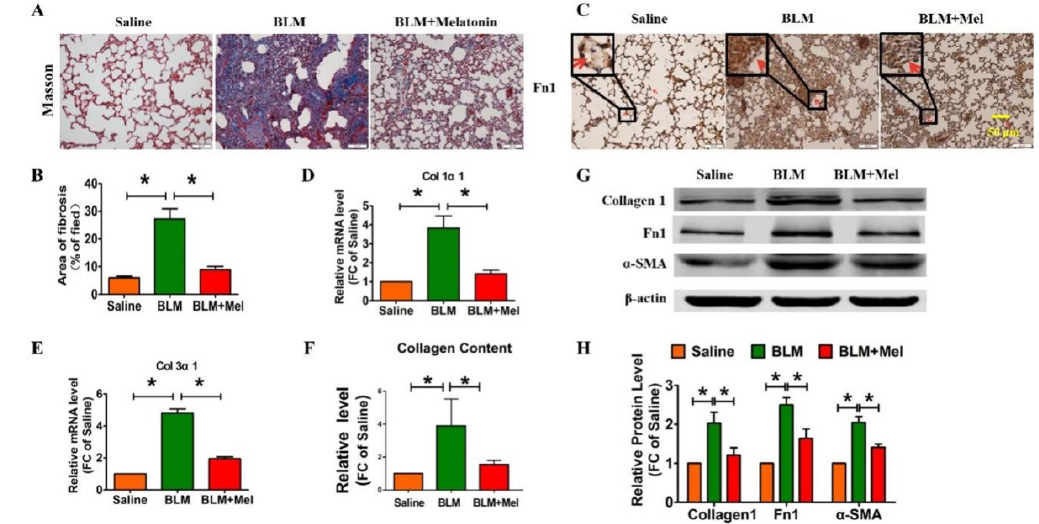
Figure 1. Melatonin alleviates bleomycin-induced pulmonary fibrosis in mice. ( A ) Representative microscopy images of Masson’s staining of lung tissue derived from BLM-treated mice or BLM + Melatonin mice; scale bar, 50 µ m; ( B ) Quantification of total interstitial fibrotic area using Image-Pro Plus; ( C ) IHC staining shows the differential expression of fibronectin 1 (Fn1). n = 6 mice in each group, red arrow indicated the expression of Fn1. The mRNA expression of Col 1 α 1 ( D ) and Col 3 α 1 ( E ) was measured via qRT-PCR. β -Actin mRNA acted as the internal control; ( F ) Collagen content of lung tissues was detected by SircolTM Soluble Collagen Assay; ( G ) Western blot analysis examining the fibrotic-related protein expression in BLM-treated mice with or without melatonin injection; ( H ) Th statistical Western blotting data. n = 4 mice in each group. Values are the mean ± SEM of five independent experiments. * p <